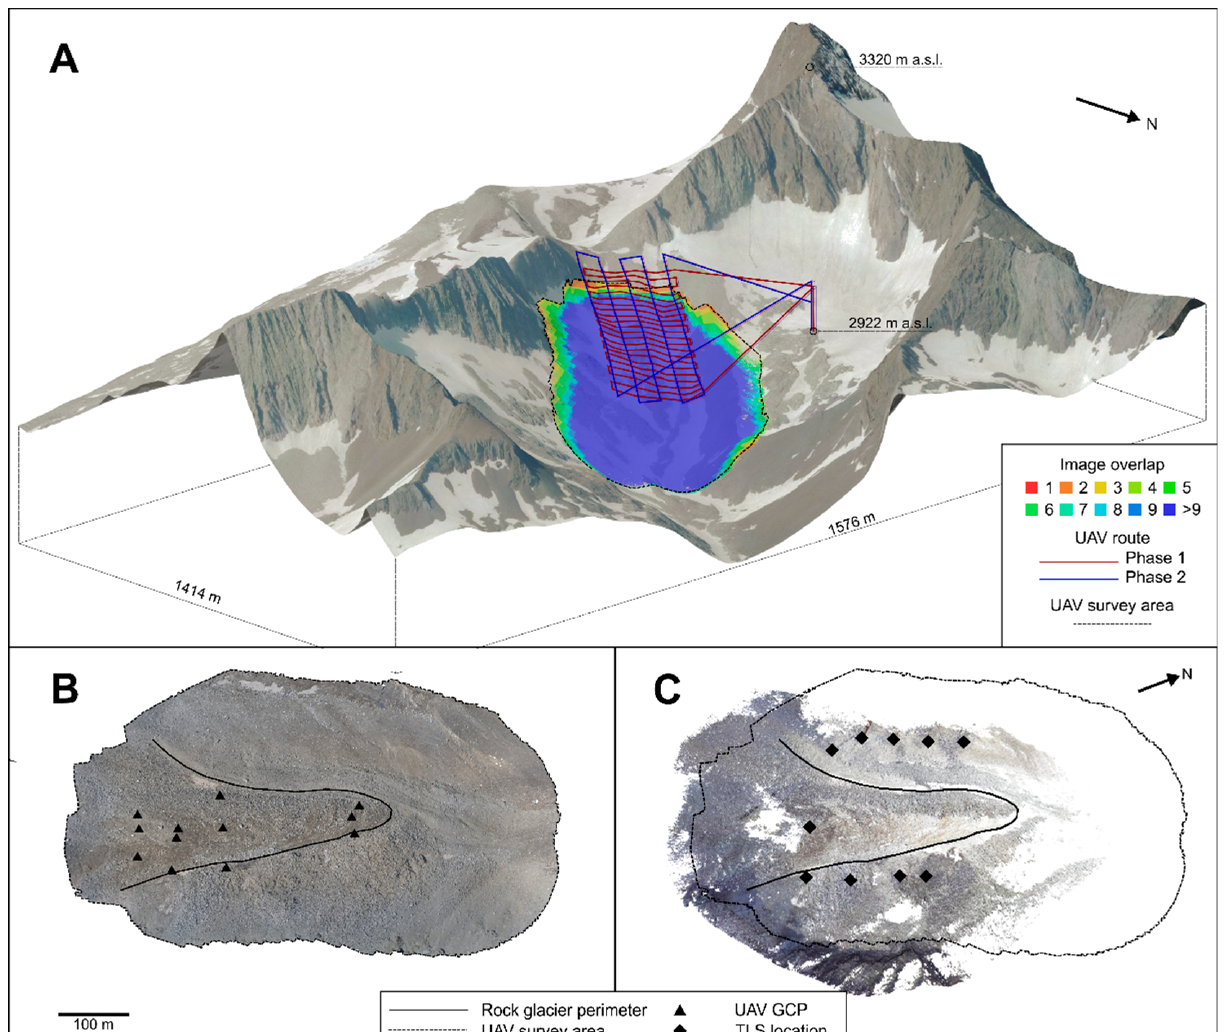
Figure 2. Data collection design and extension. ( A ) UAV flight design, image overlap, and area surveyed during the photogrammetric flight. ( B ) Ground control points location used in the UAV flights over the surveyed area. ( C ) TLS benchmark surveyed area and scan placements.